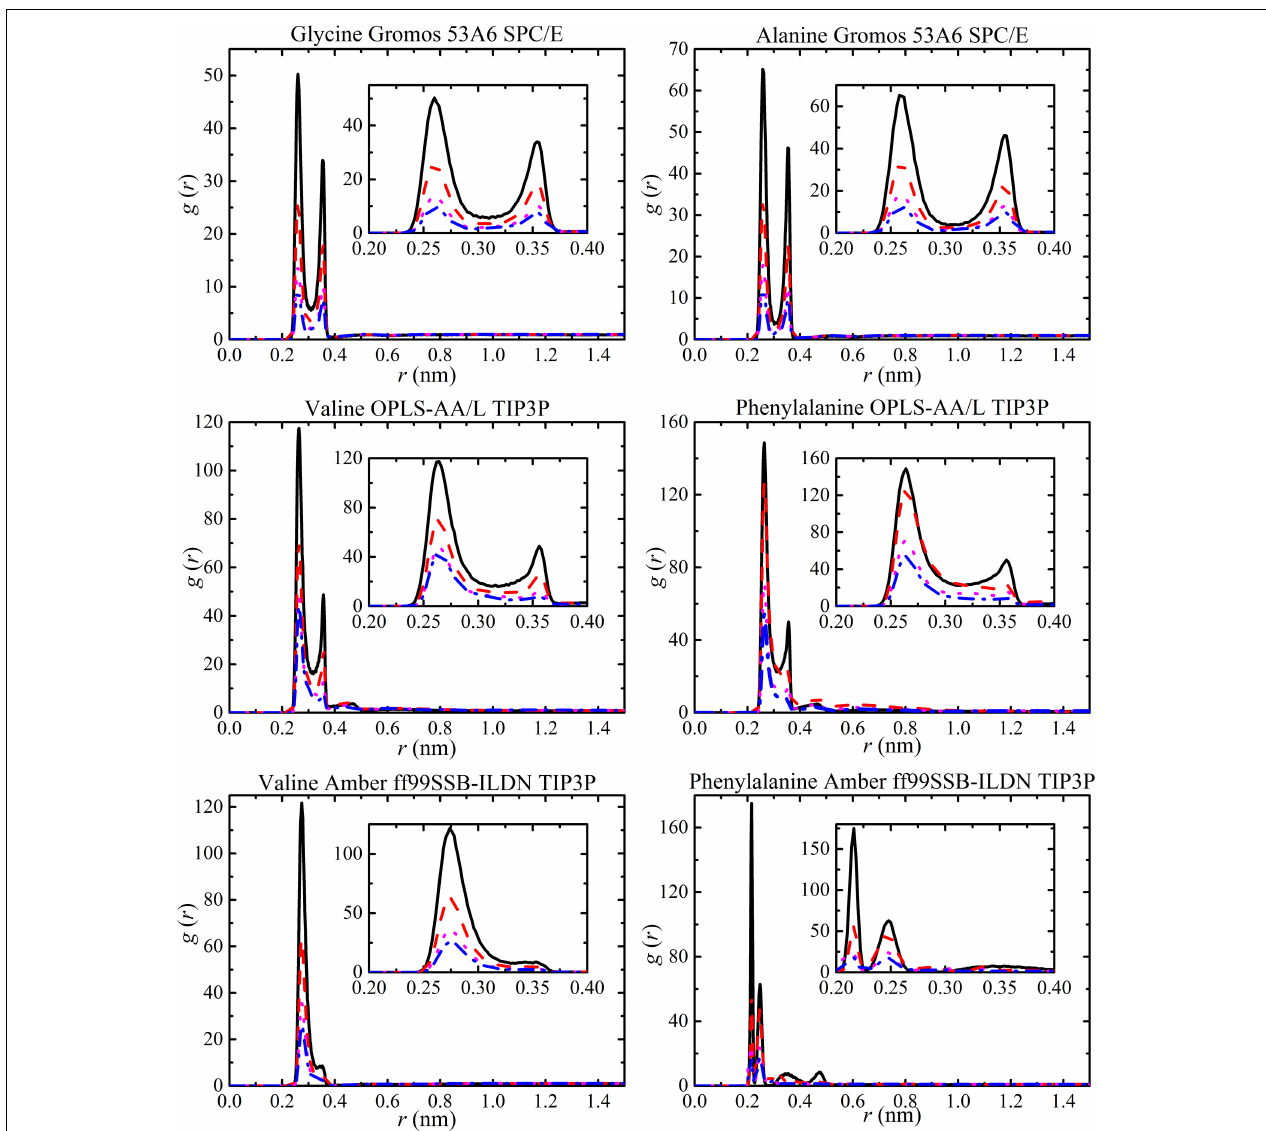
FIGURE 8 | RDFs of the carboxylate oxygen and amine nitrogen of each amino acid at different amino acid concentrations [i.e., 50 ( ), 100 ( ), 200 ( ), and 300mg/ml ( )] and different force fields at 298 K.